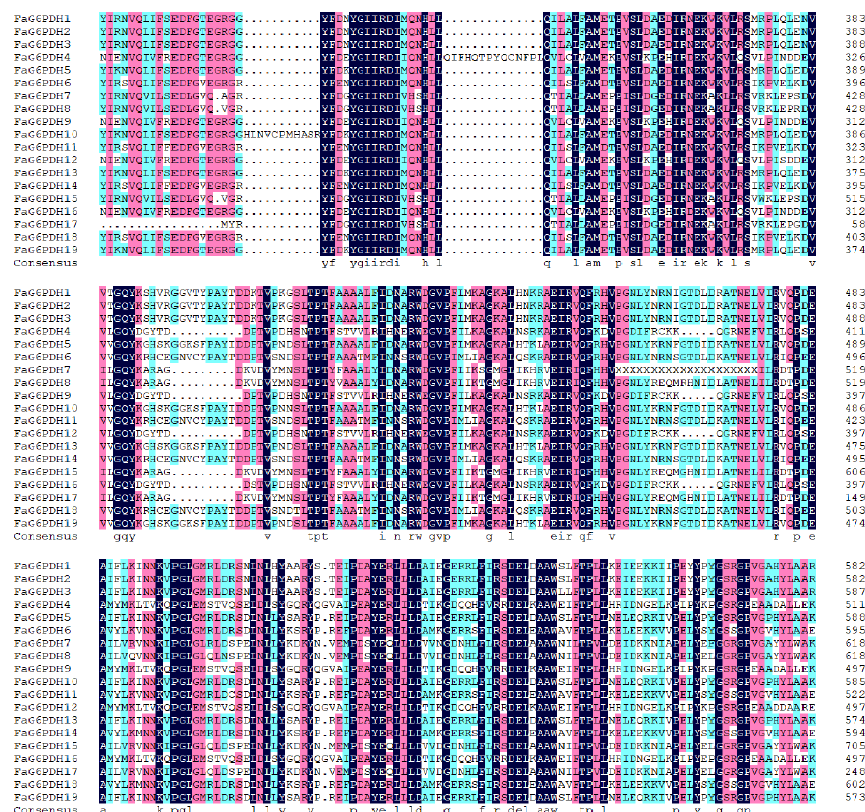
Figure 2. Multiple sequence alignment of the FaG6PDH domains.